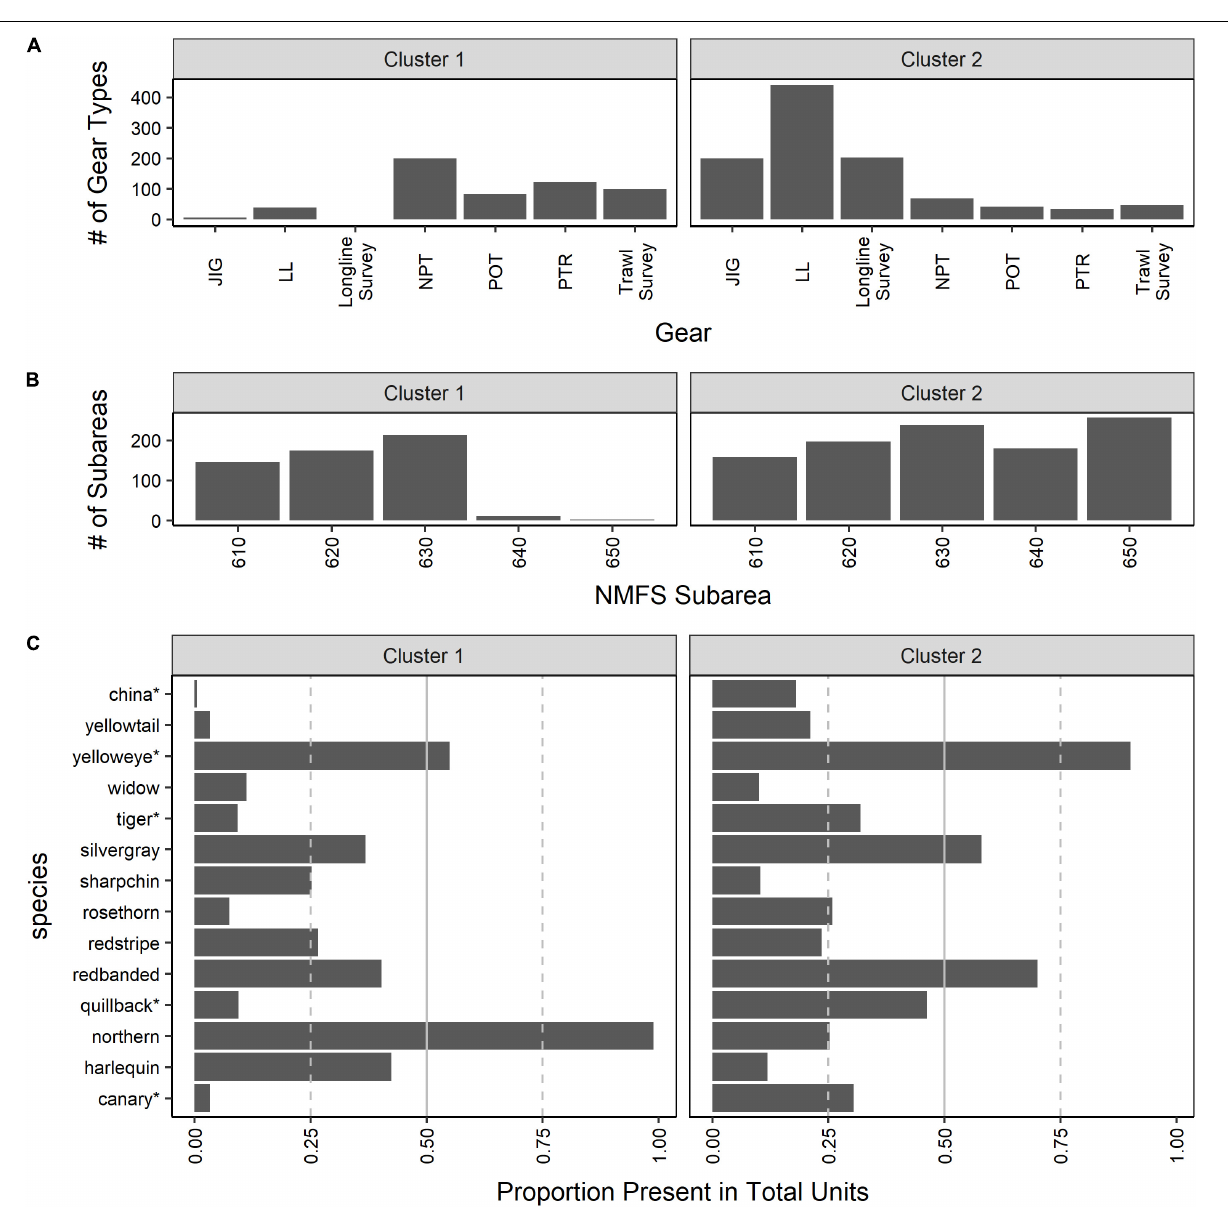
FIGURE 6 | Results from Q-mode k -mediods using the proportions matrix with “units” (year-month-subarea-gear) to synthesize all gear types (fishing gear: jig [JIG], longline hook and line [LL], non-pelagic trawl [NPT], pot [POT], and pelagic trawl [PTR]; and surveys: longline and trawl) and subareas into one dataset when k = 2 clusters. In (A) the number of units where each gear type was present in each cluster is shown. In (B) the number of units where each subarea were present in each cluster is illustrated. In (C) the proportion of units (year-month-subarea-gear) that a species is present out of the total number of units assigned to each cluster is provided to represent the species composition in each suggested cluster when k = 2. Species that currently belong to the Demersal Shelf Rockfish complex are indicated by